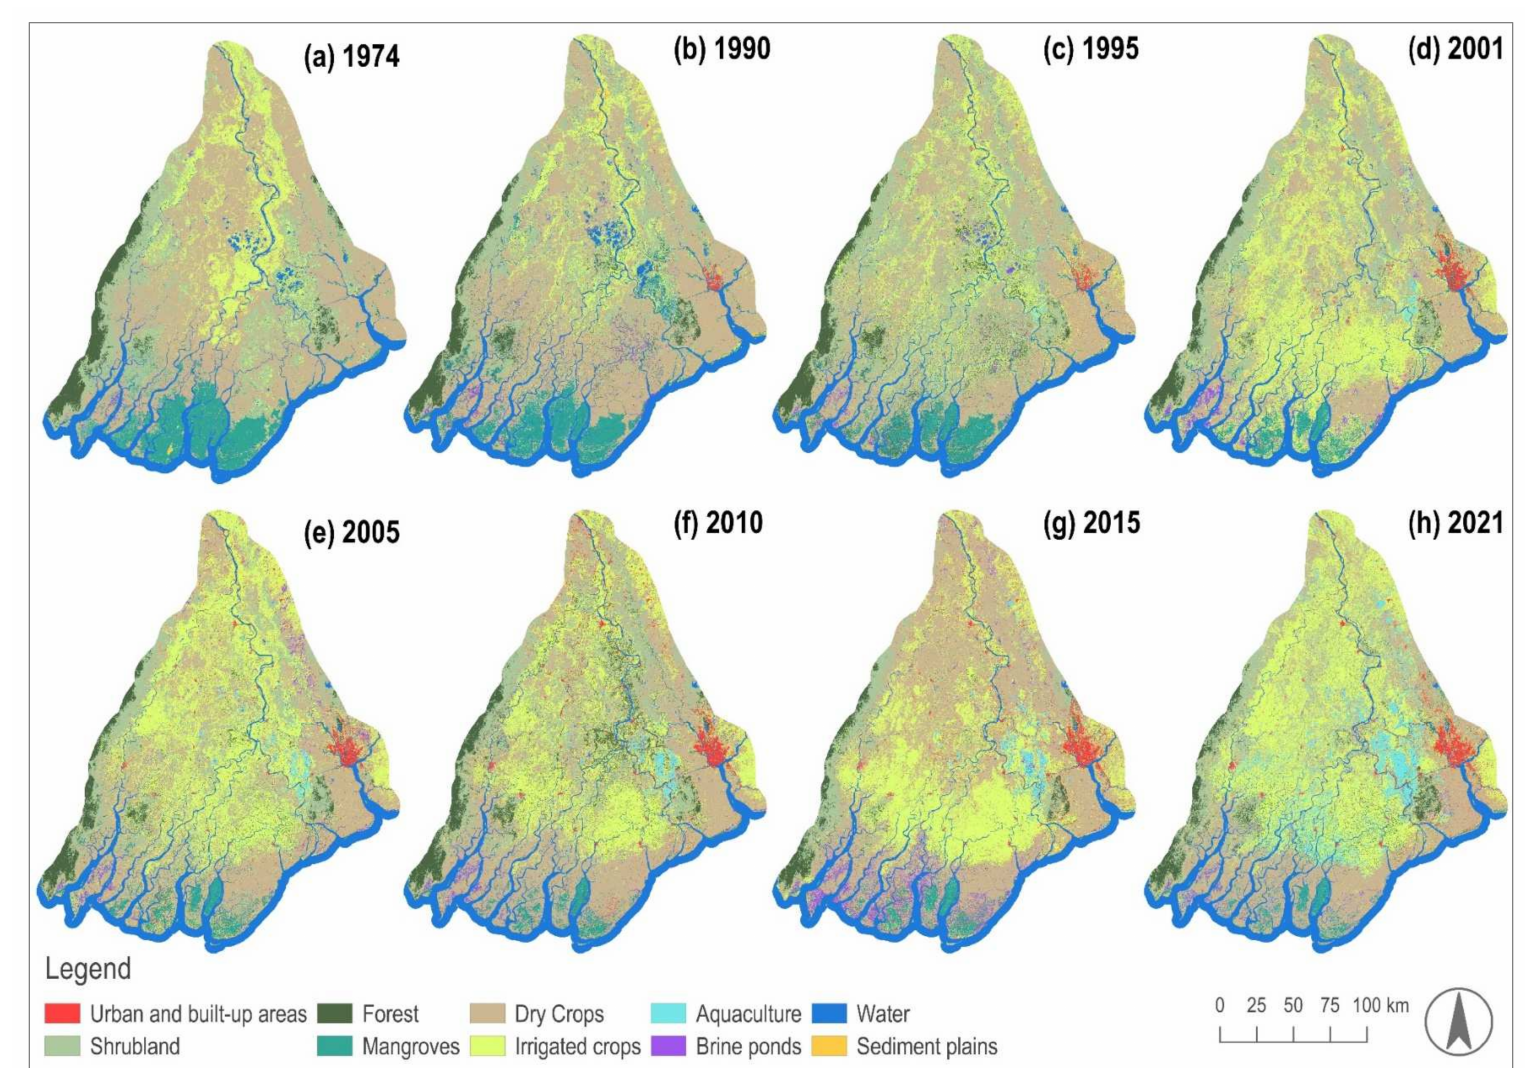
Figure 4. Land cover classification products for the Ayeyarwady Delta from 1974 to 2021 ( a – h